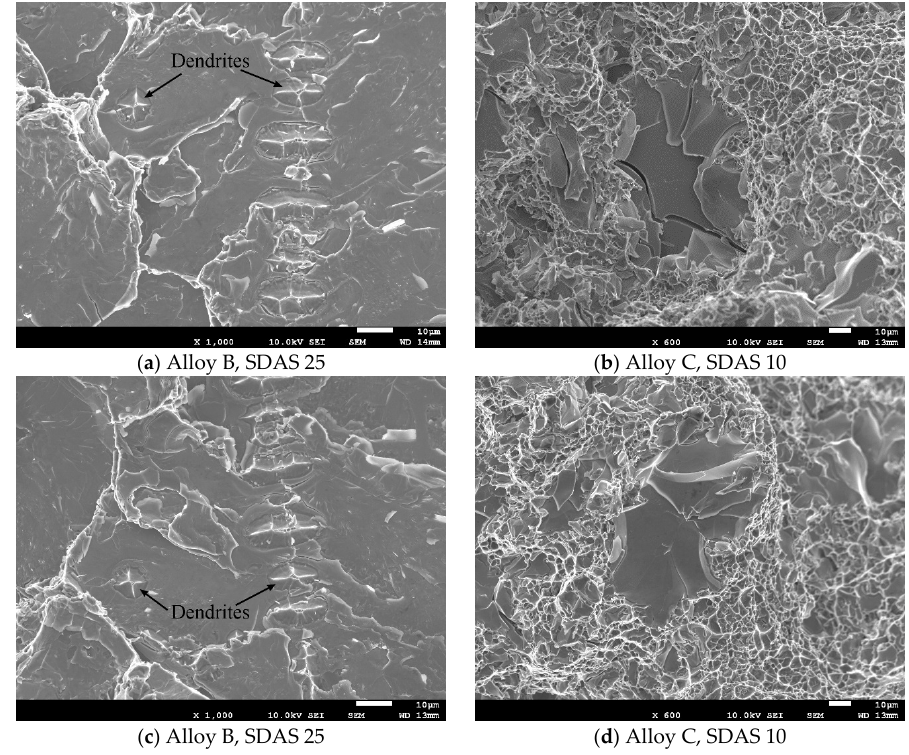
Figure 8. The images show opposite fracture surfaces where ( a , c ) shows cleaved β‐ particles and ductile fracture of dendrites through the platelet. Image ( b , d ) shows a cleaved sludge particle.